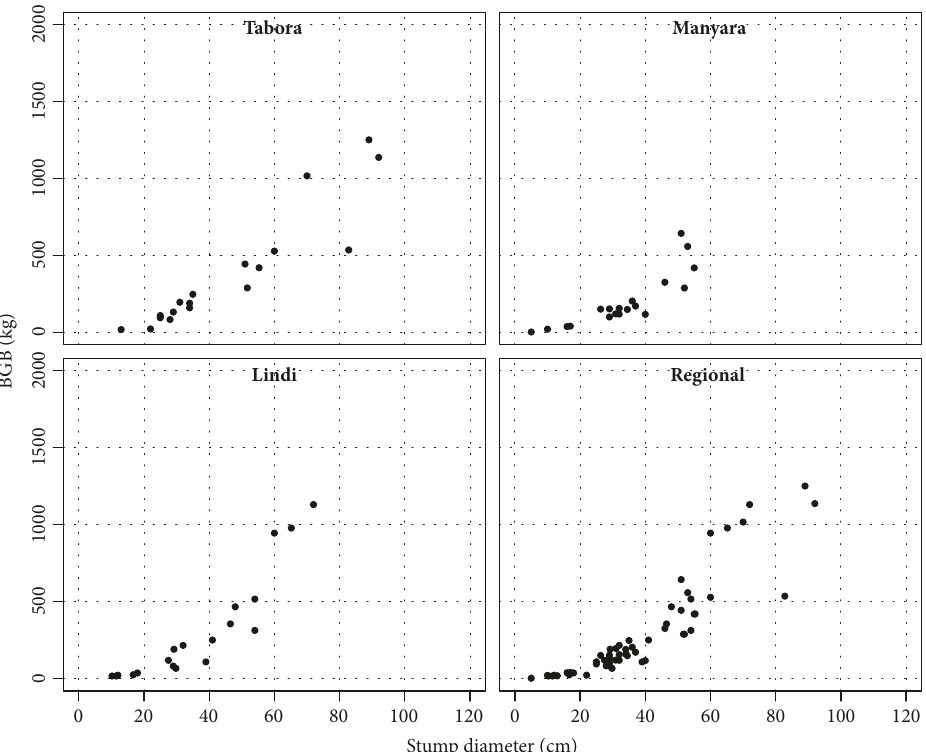
Figure 4: Scatter plots of sample trees belowground biomass distribution versus stump diameter for the three sites and for all sites combined.